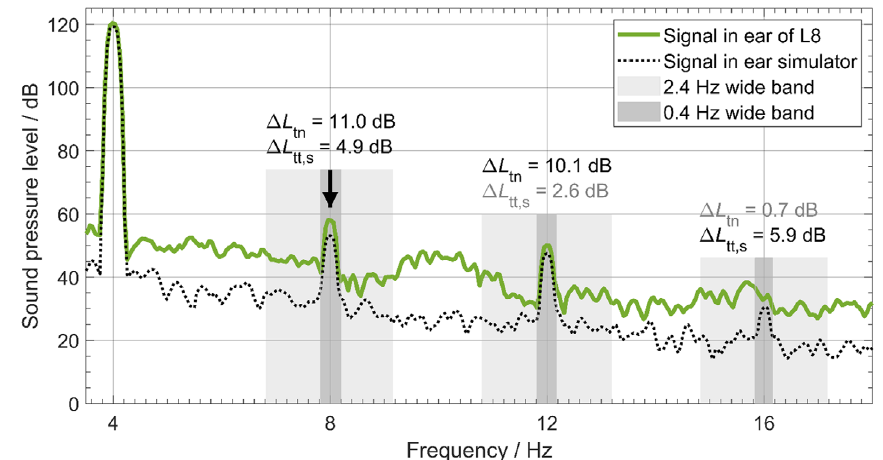
Figure 5. Example magnitude spectra to visualize the criteria for the detection of ear-generated distortions. To this end, a portion of the spectra of the bottom left panel of Figure 4 is redrawn. The dark gray boxes indicate the 0.4 Hz wide frequency bands around the higher harmonics that were used to derive their power spectral densities. The light gray boxes indicate the 2.4 Hz wide frequency bands around the higher harmonic that were used to estimate the power spectral density of the noise. From these two quantities, a tone-to-noise ratio was calculated and expressed as a level difference D L tn . In addition, the ratio between the power in the narrow frequency band around the higher harmonics between the spectrum recorded in the listener ’ s ear and that recorded in the occluded-ear simulator was computed and expressed as a level difference D L tt,s . Based on these measures, it was decided whether an ear-generated distortion product is present (indicated by the black arrow) or not (see text for